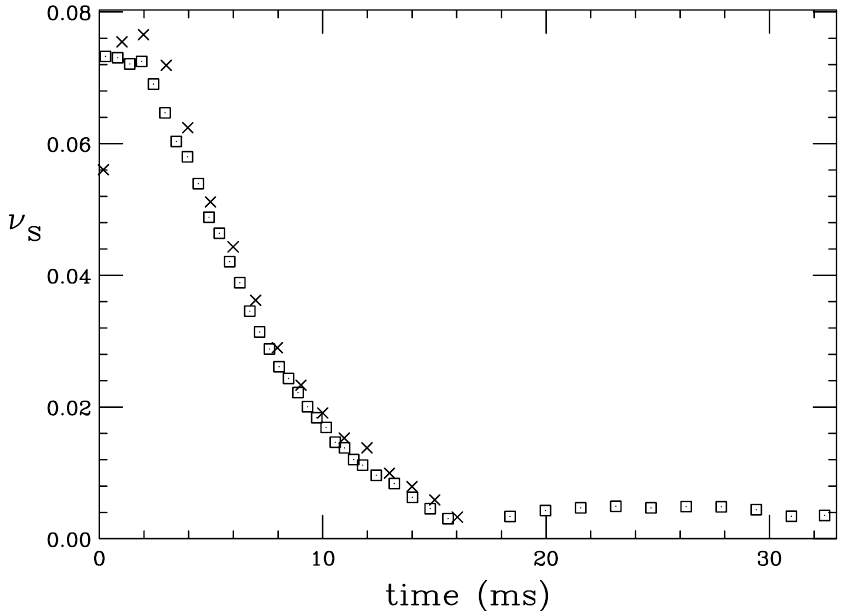
FIG. 11. The synchrotron tune in a booster cycle. The squares are measured from turn-by-turn data with ICA method. The crosses are measured from phase signal with synchrotron phase detector (SPD) as in Ref. [9]. Note that the SPD method has difficulty in measuring the synchrotron tune above the transition energy at around the 14.5